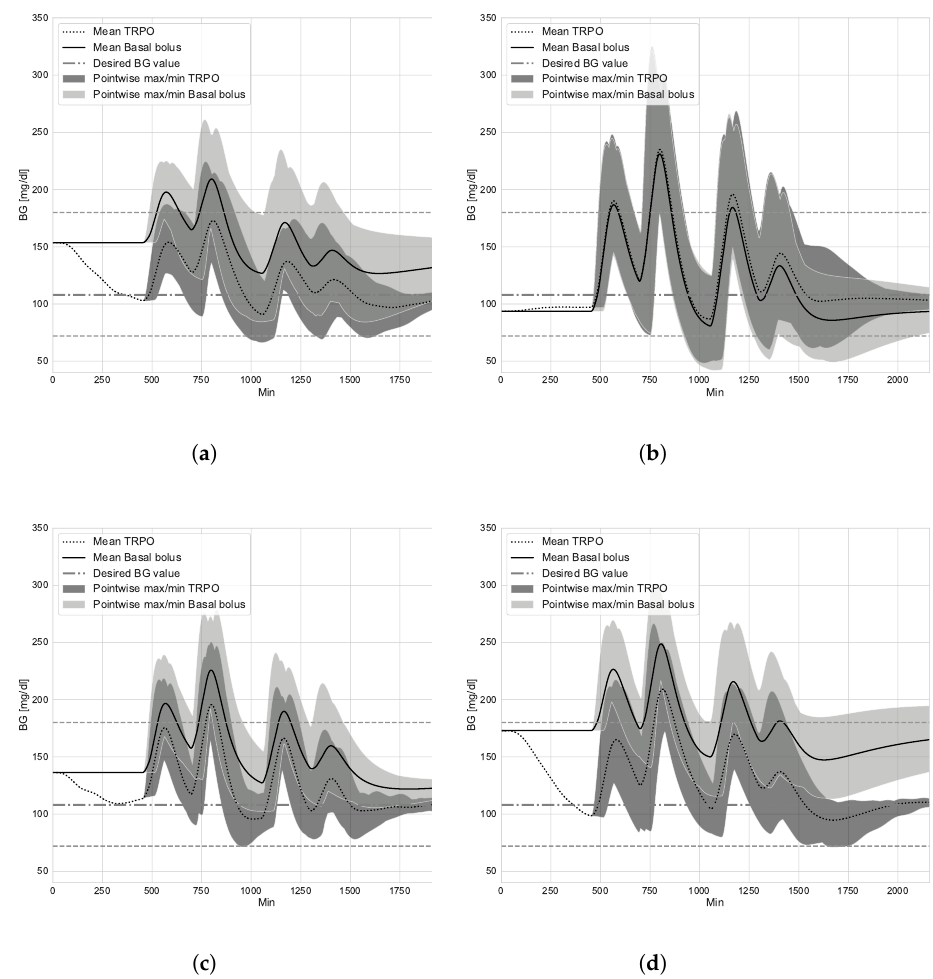
Figure 6. A random sample from the 100 virtual patients ( a ) patient #0, ( b ) patient #4, ( c ) patient #17, and ( d ) patient #38. All figures show results from the sub-optimal basal-bolus treatment and the TRPO agent trained on each patient